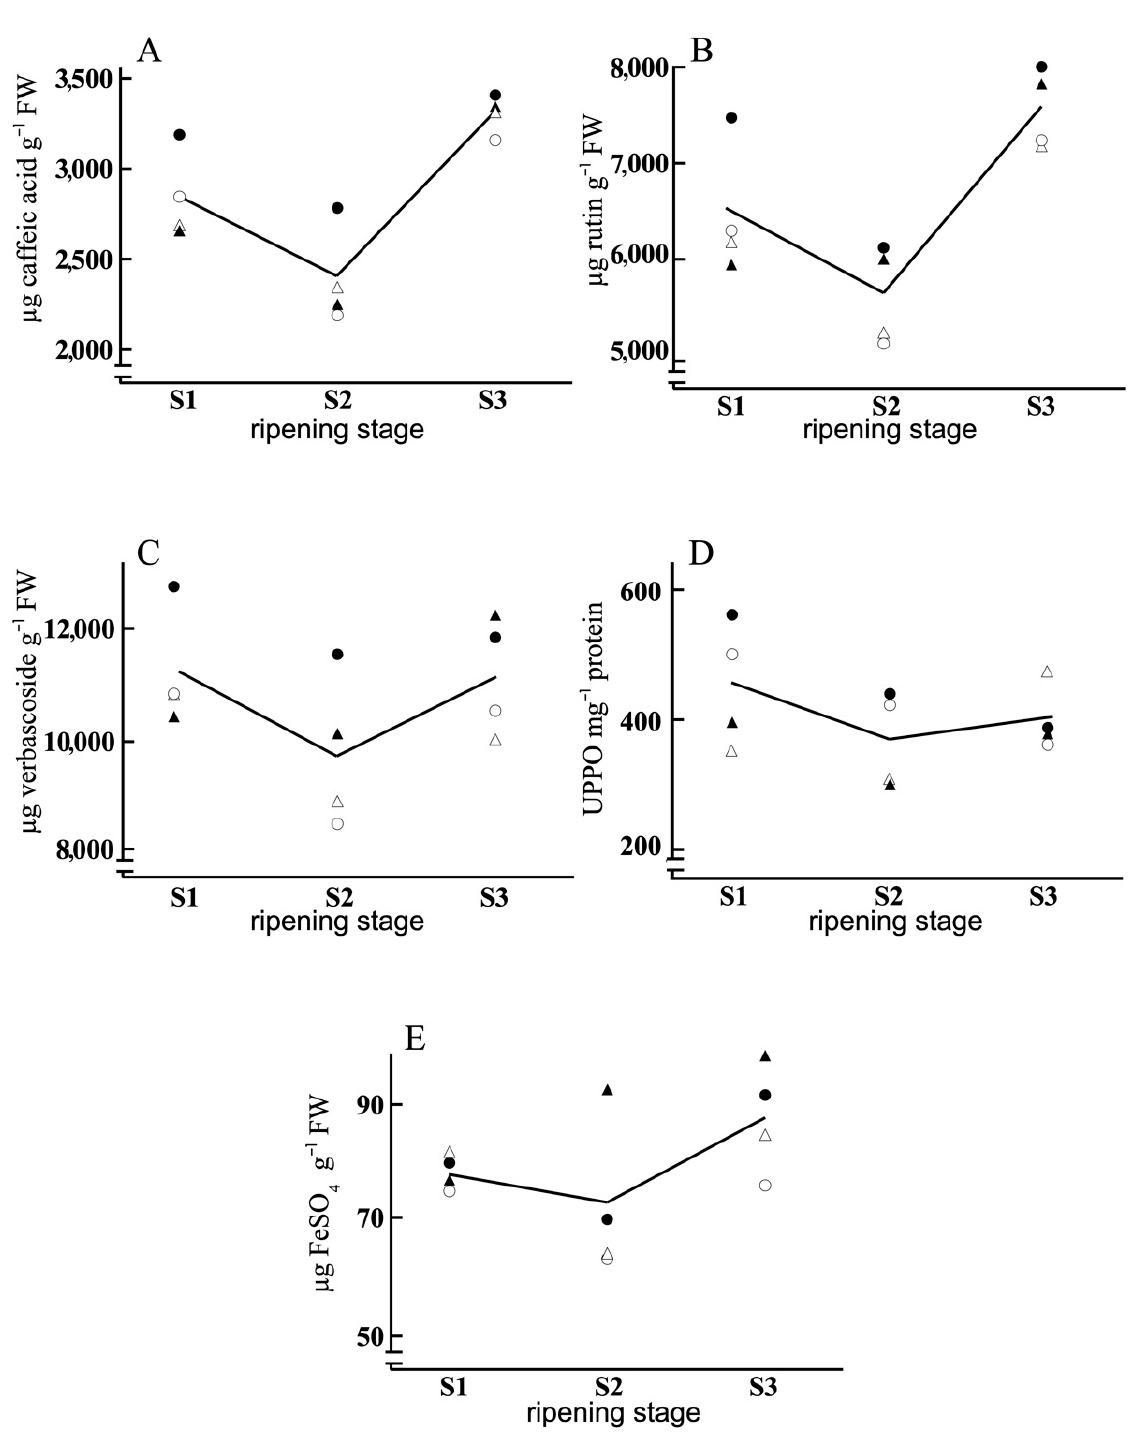
Figure 4. Line plots corresponding to total phenol ( A ), flavonoid ( B ) and PPG ( C ) contents; PPO activity ( D ); and FRAP ( E ) of olives of Morisca NI – ● –, Morisca FI – ○ –, Manzanilla NI – ▲ – and Manzanilla FI – △ –, for each ripening stage (derived from Table S3).